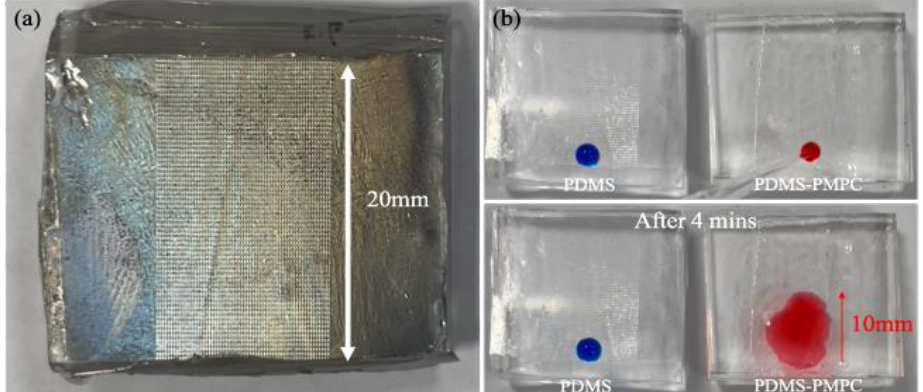
Figure 14. ( a ) The liquid channels (20 mm) of the PDMS-based substrate were used for the channels of the real Nepenthes peristome; ( b ) the stained deionized water (10 µ L) was used for the one-way of the real Nepenthes peristome; ( b ) the stained deionized water (10 μL ) was used for the one-way liquid transfer capability (blue water for PDMS and red water for PDMS-PMPC). liquid transfer capability (blue water for PDMS and red water for PDMS-PMPC).